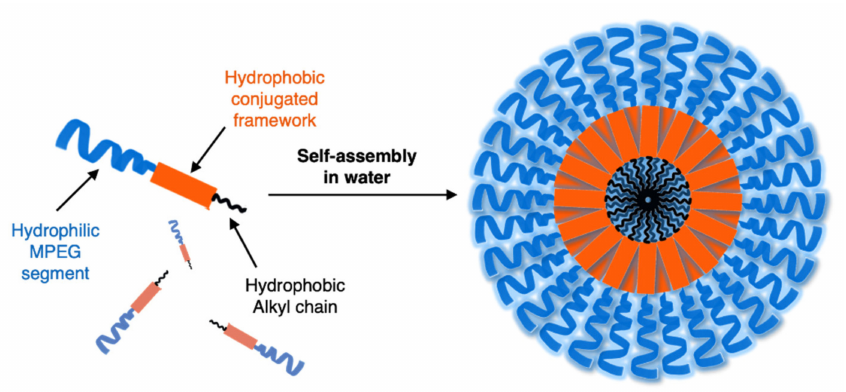
Figure 1. Schematic representation of amphiphilic OPE and its self-assembly into nanoparticles in